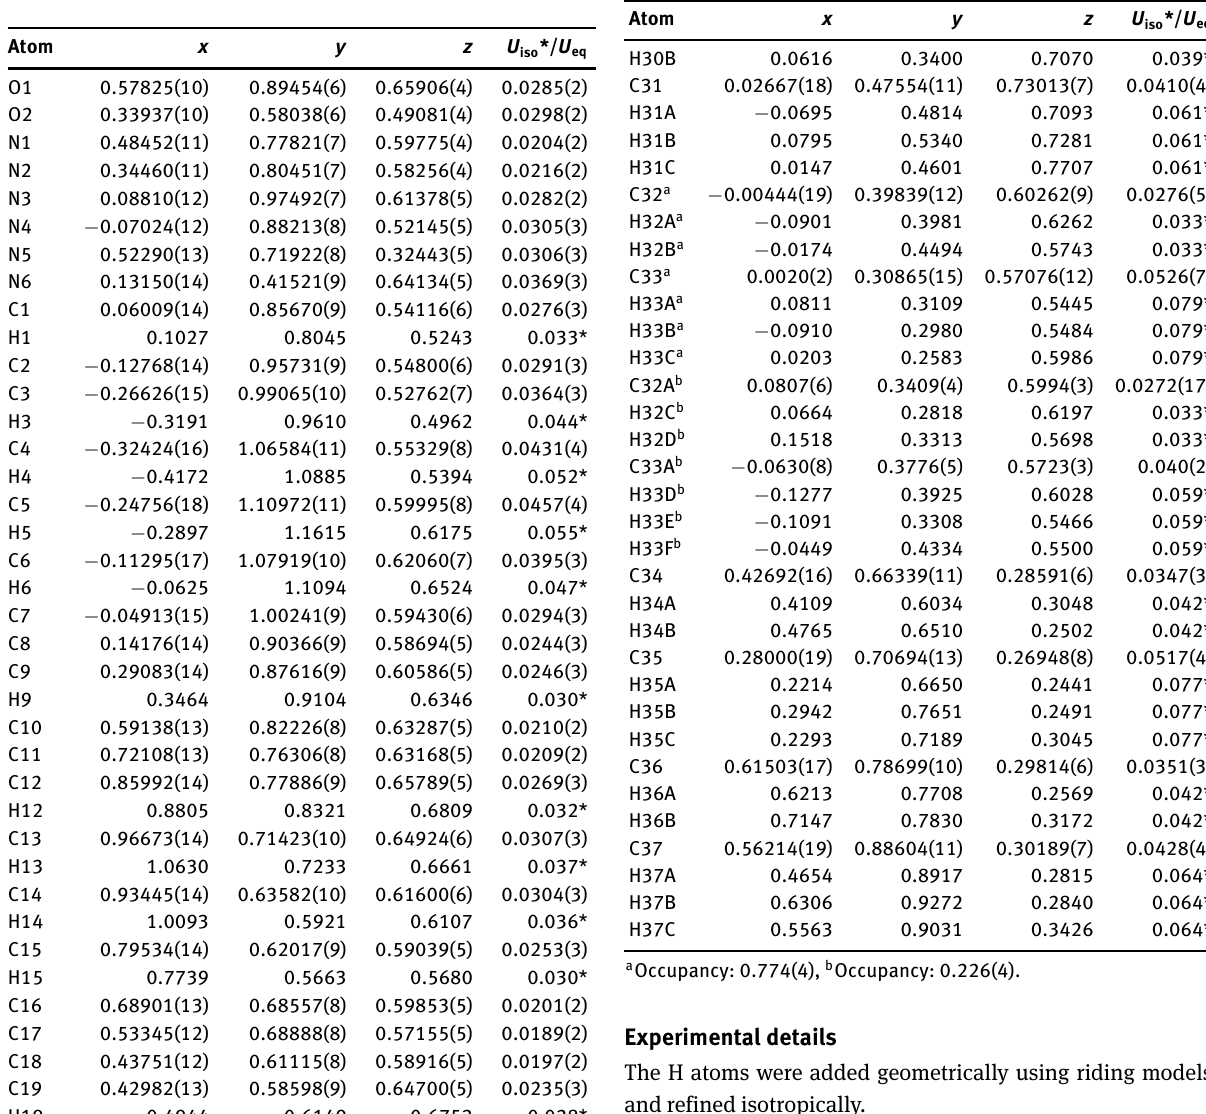
Table 2: Fractional atomic coordinates and isotropic or equivalent isotropic displacement parameters (Å 2